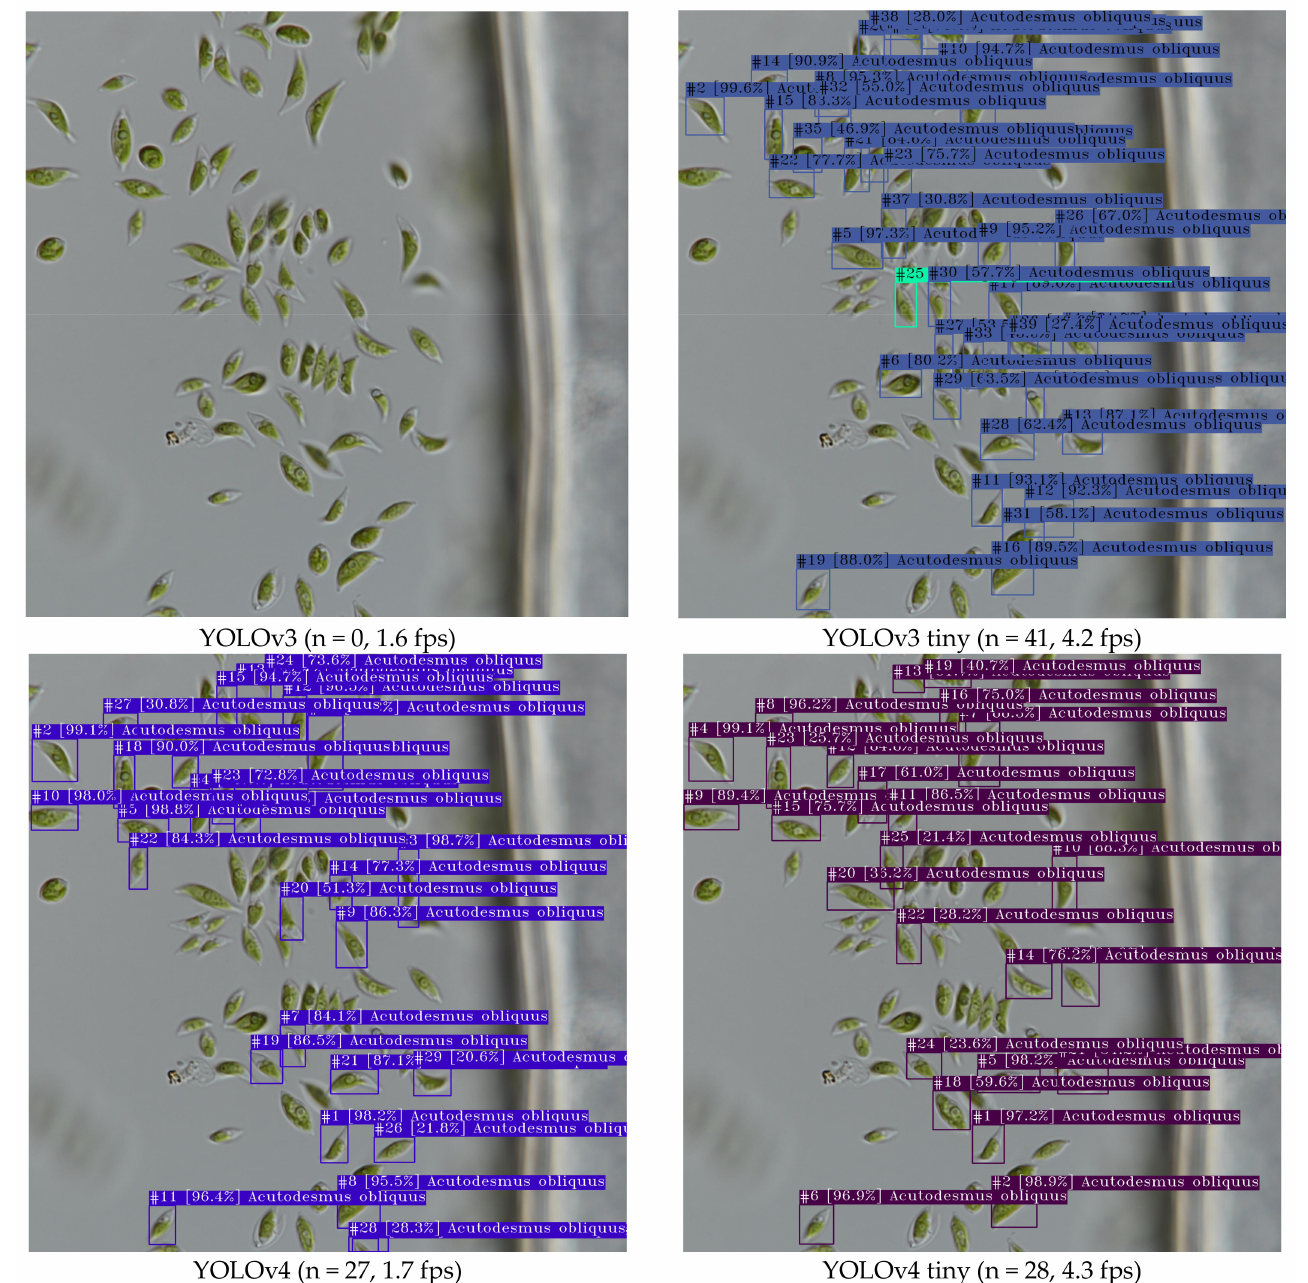
Figure 5. Comparison of the algal detection model performance with densely distributed relatively small-size algal cell